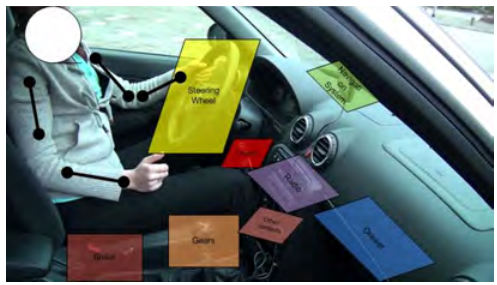
Figure 12. Regions of interest inside a